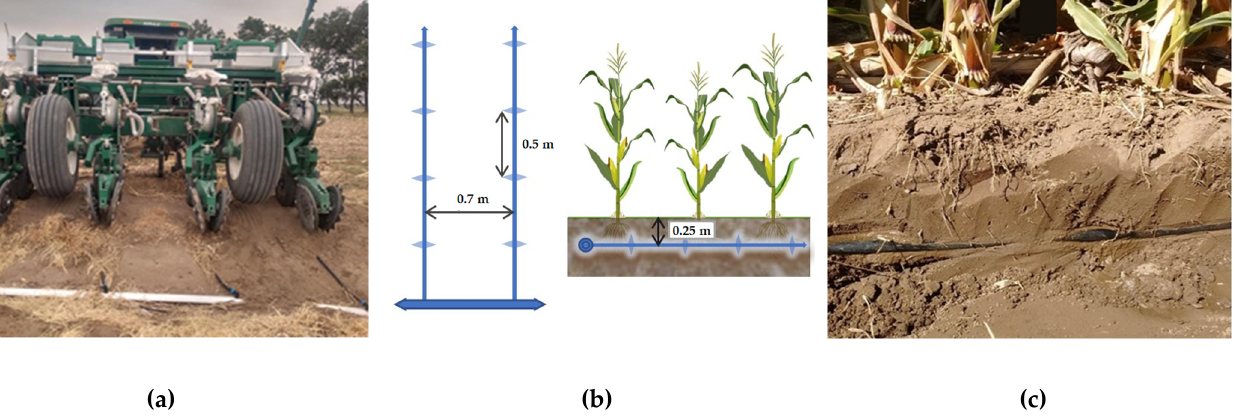
Figure 1. ( a ) Mechanized seeding, rear view on one of the headers of the field; ( b ) schematic view (top and transverse) of the subsurface drip irrigation system (SDI); ( c ) soil profile with the irrigation line at 0.25 m